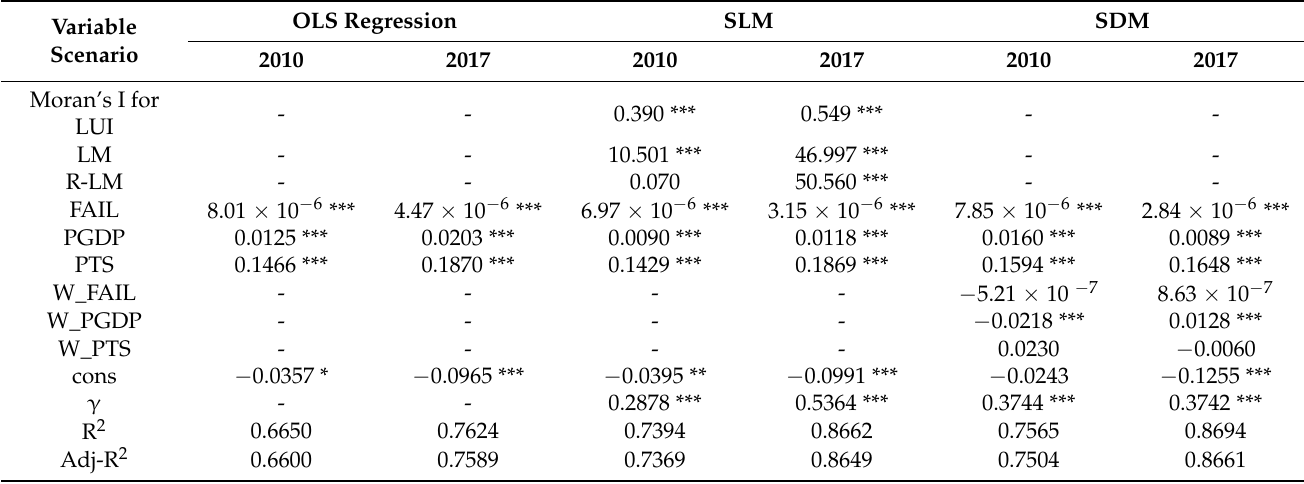
Table 4. Results of OLS regression, SLM, and SDM in 2010 and